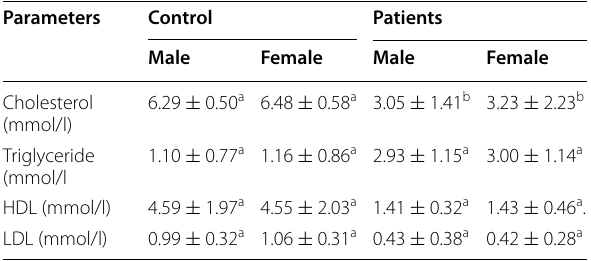
The values are expressed as mean each group Values with different superscript letters in the same row are significantly different from each other ( P